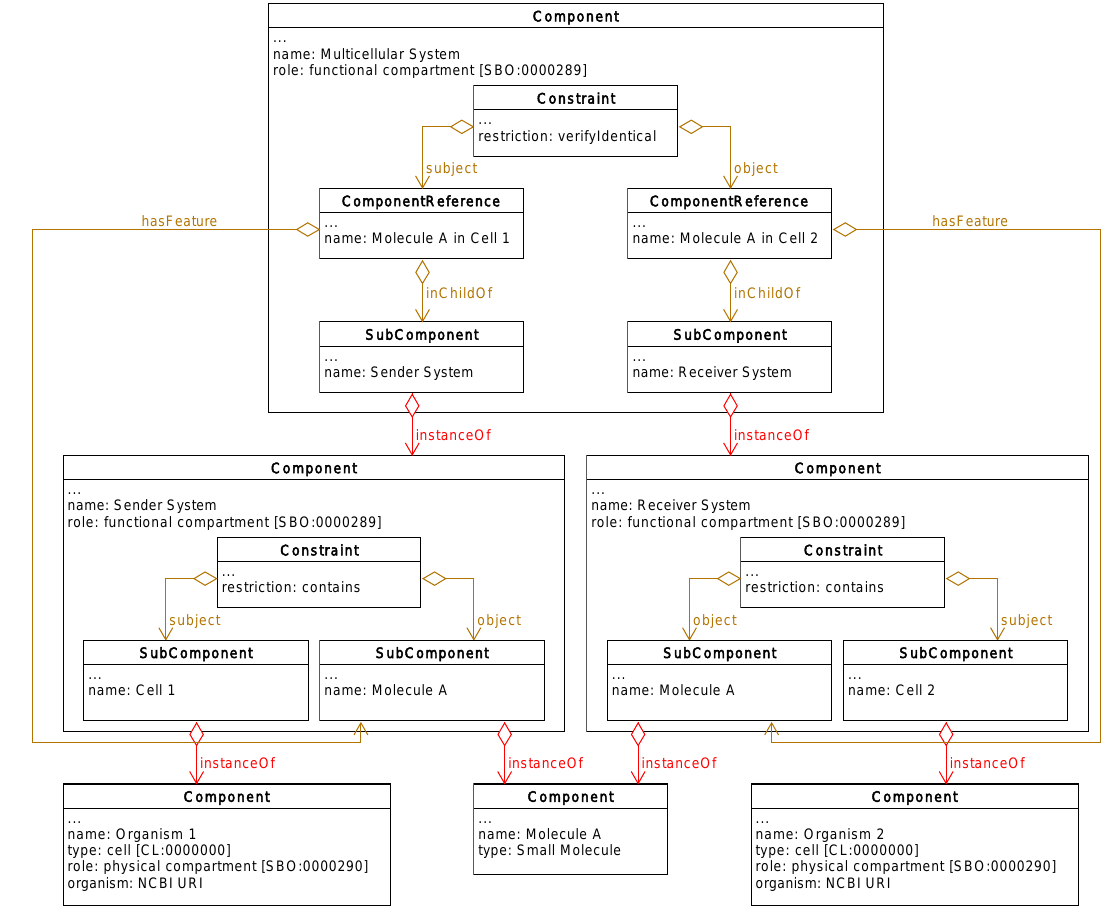
Figure 23: Captured here is a design involving two cells which both interact with the small molecule “Molecule A”. Designs for the sender and receiver systems are captured using constraint to show that each of these cells interacts with the Molecule A contained within it. The overall multicellular system is represented by a Component with a role of “functional compartment”, which is an SBO term. The two systems are included in this multicellular design as Feature s, and the fact that Molecule A is shared between systems is indicated with a constraint.